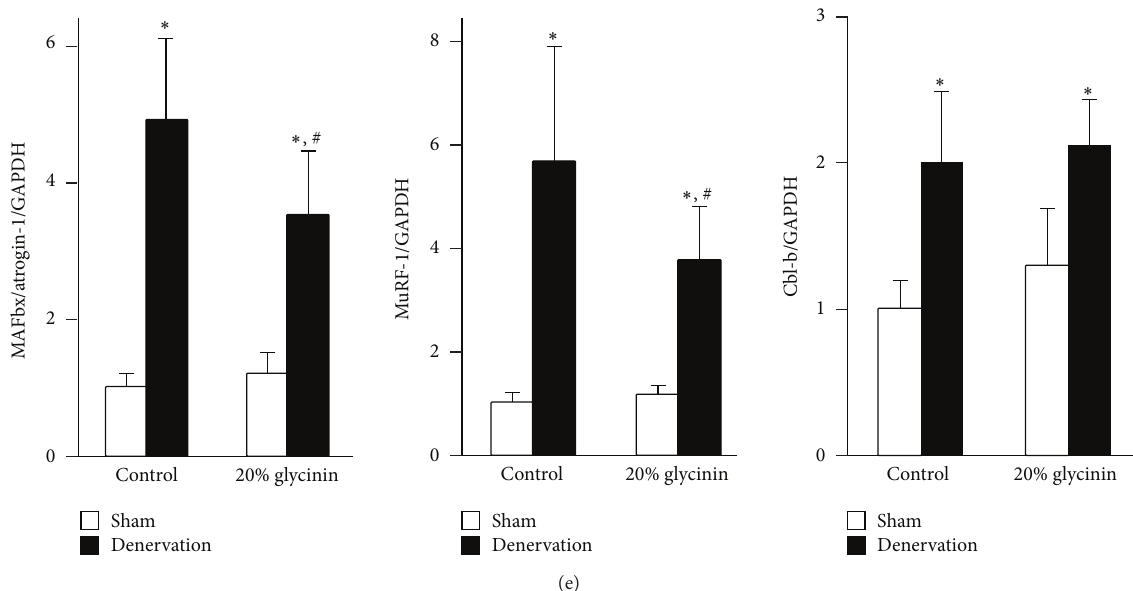
Figure 6: Effects of dietary soy glycinin protein on IGF-1 signaling in denervated muscle. The right and left legs of C57BL/6 mice were subjected to denervation and sham operation, respectively. The mice were fed with 20% casein (control) or 20% soy glycinin diet from 1 week before denervation till the end of the experiment. TA muscles were isolated at days 1, 3, 3.5, and 4 after denervation. (a) Homogenates of TA muscles isolated were subjected to immunoblotting (IB) for IRS-1 and actin on the indicated days after denervation. (b–d) Homogenates of TA muscles isolated from mice fed with control or 20% glycinin diet at 3.5 days after denervation were subjected to IB for IRS-1 and actin (b) and phosphorylated Akt-1 and total Akt-1 (d). The densitometric analysis of these images was performed with ImageJ software. Data are mean ± SD ( 𝑛 = 3 ). ∗ 𝑃 < 0.05 versus sham operation; # 𝑃 < 0.05 versus control diet in denervated muscle. Immunoprecipitates (IP) from the TA muscles with an anti-IRS-1 antibody were subjected to IB for ubiquitin (c). Representative findings of five experiments with matching results. (e) Expression levels of MAFbx/atrogin-1, MuRF-1, Cbl-b, and GAPDH (internal control) transcripts in TA muscle analyzed by real- timeRT-PCR.Thelevelofeachtranscriptwasnormalizedtosham-operatedmicefedwithcontroldiet.Dataaremean ± SD( 𝑛 = 5 ). ∗ 𝑃 < 0.05 versus sham operation; # 𝑃 < 0.05 versus control diet in denervated